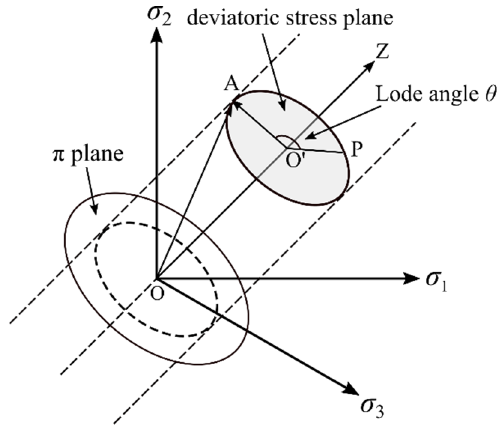
Figure 1. Illustration of the Lode angle in the principal stress space.